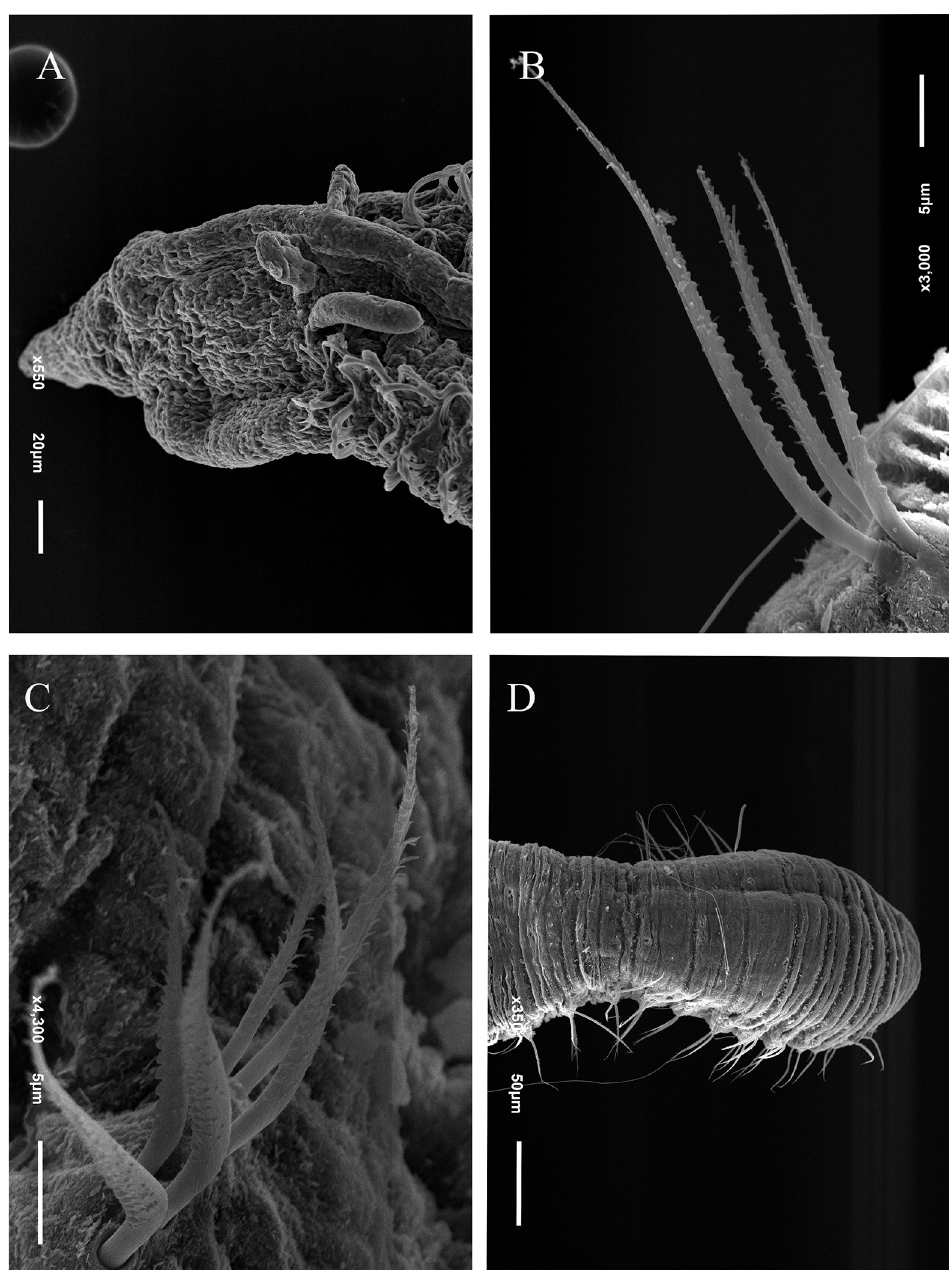
Fig 10. Kirkegaardia papaveroi sp. nov. (A) Anterior end, lateral view; (B) notopodial capillary denticulated; (C) neuropodial capillary denticulated; (D) posterior end, dorsal